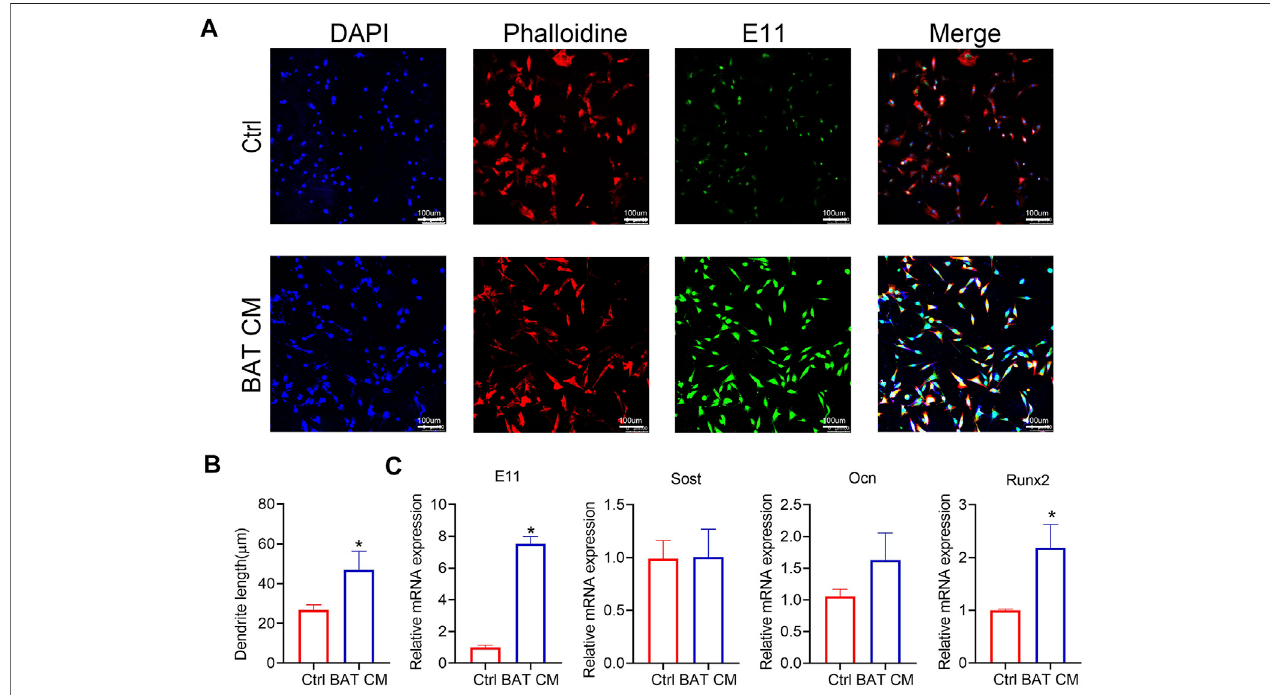
FIGURE 5 | BAT CM increase the length of osteocyte ‘ sdendrites. (A,B) Immuno fl uorescent staining was performed to show the morphology of MLO-Y4 and dendriteslengtharecalculated. (C) Relative mRNAexpression levelsofE11,Sost,and Ocnweredetected byRT-PCR. Dataareshownasmean ± SD(n ≥ 3per group). Signi fi cance( p value)iscalculatedusingstudent ’ st-test,* p < 0.05;Abbreviations:1 day(1d),14 days(14d),28 days(28d),Normal:miceintheroomtemperature(23 ° C), Cold: mice in the 4 °